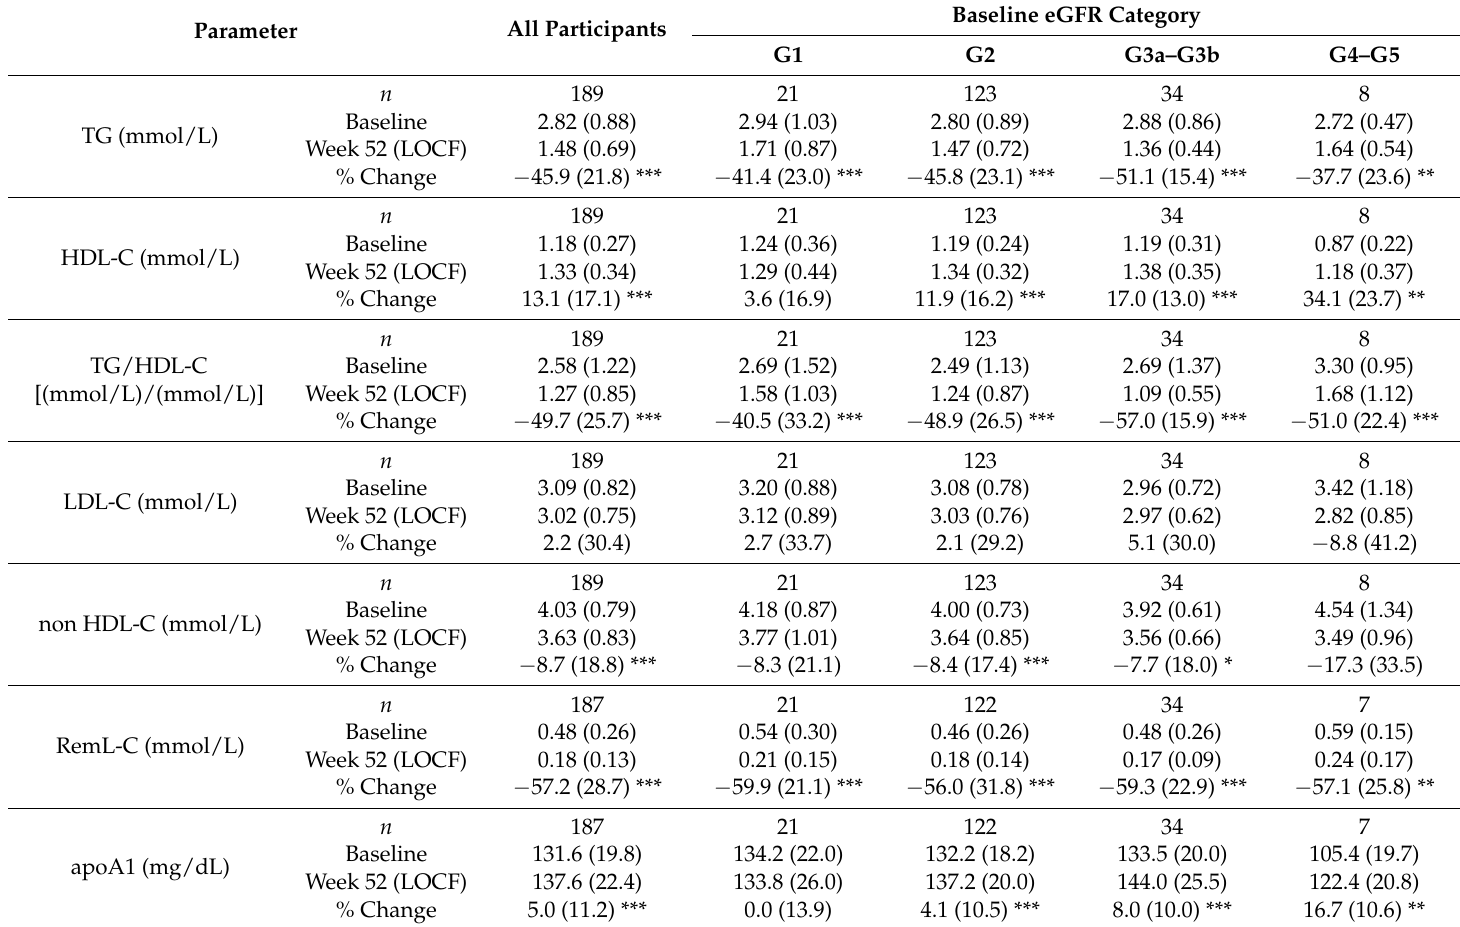
Table 2. Changes from baseline in lipid levels and inflammatory parameters during the 52-week treatment